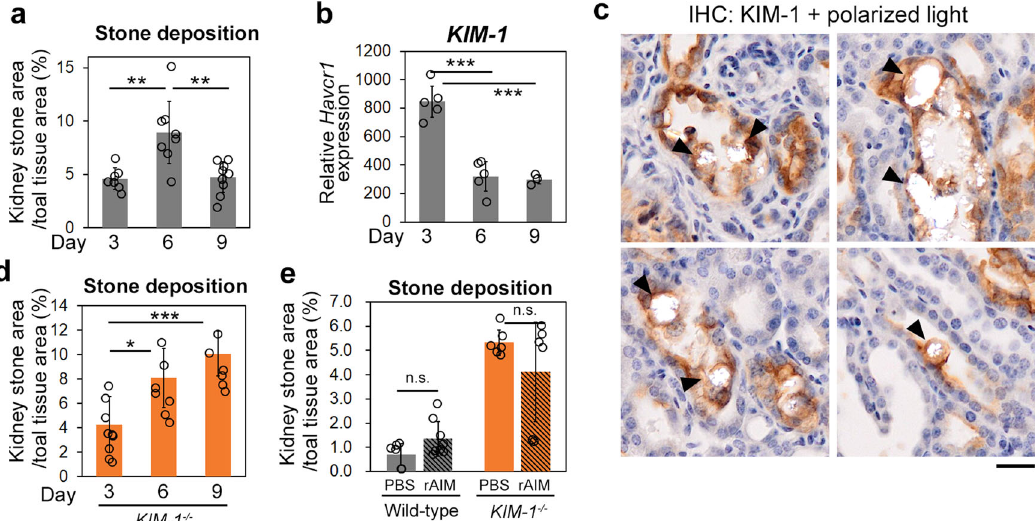
Fig. 6 Removal of developed stones by KIM-1. a Mice were injected with glyoxylate (150 mg/kg bodyweight) daily for 9 days and the amount of kidney stones was analyzed in mice on days 3, 6, and 9. n = 7 – 9. b The mRNA levels of Haver1 ( KIM-1 ) in the kidney of the mice above. c Immunohistochemistry for KIM-1 on kidney specimens from mice on day 6 of glyoxylate loading. A representative photograph is presented. KIM-1 (brown) surrounding a stone is indicated. Scale bar: 20 µ m. d The amount of kidney stones in KIM-1 − / − mice on days 3, 6, and 9 of glyoxylate loading. n = 6 – 9. e Wild-type and KIM-1 − / − mice were loaded with glyoxylate for 6 days to develop kidney stones, and thereafter injected daily with rAIM (400 μ g) or PBS from day 6. On day 9, the mice were sacri fi ced and the amount of kidney stones was analyzed. n = 6 – 8. Scale bar: 20 µ m. Means ± s.d. are shown. Statistical analysis was performed with one-way ANOVA followed by Bonferroni ’ s post hoc test ( a , b , d ), or Welch ’ s t -test in each genotype group ( e ).